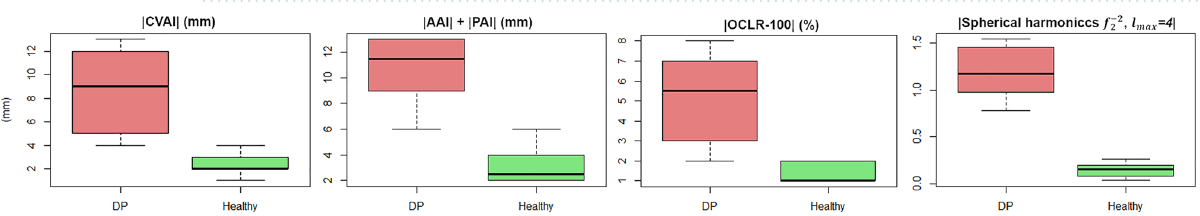
Figure 5. Values of asymmetry index, and normalized OCLR and coefficients of f groups of healthy heads (H) and heads with DP (P). Negative and positive values indicate right and left side plagiocephaly (depressed back side area of the head) respectively.